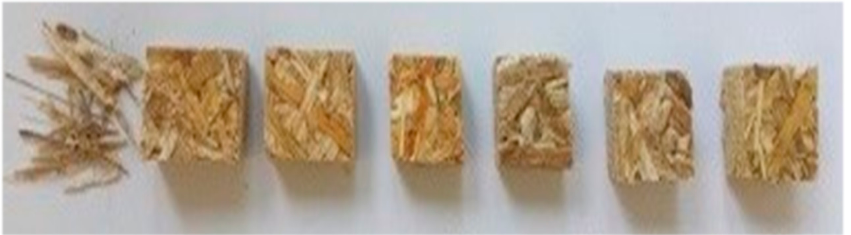
Figure 1. The samples (from left to right): rape straw, epoxy sample, epoxy-H 2 O sample, epoxy-NaOH sample, glue-LS sample, glue-LS-H 2 O sample, glue-LS-NaOH sample.